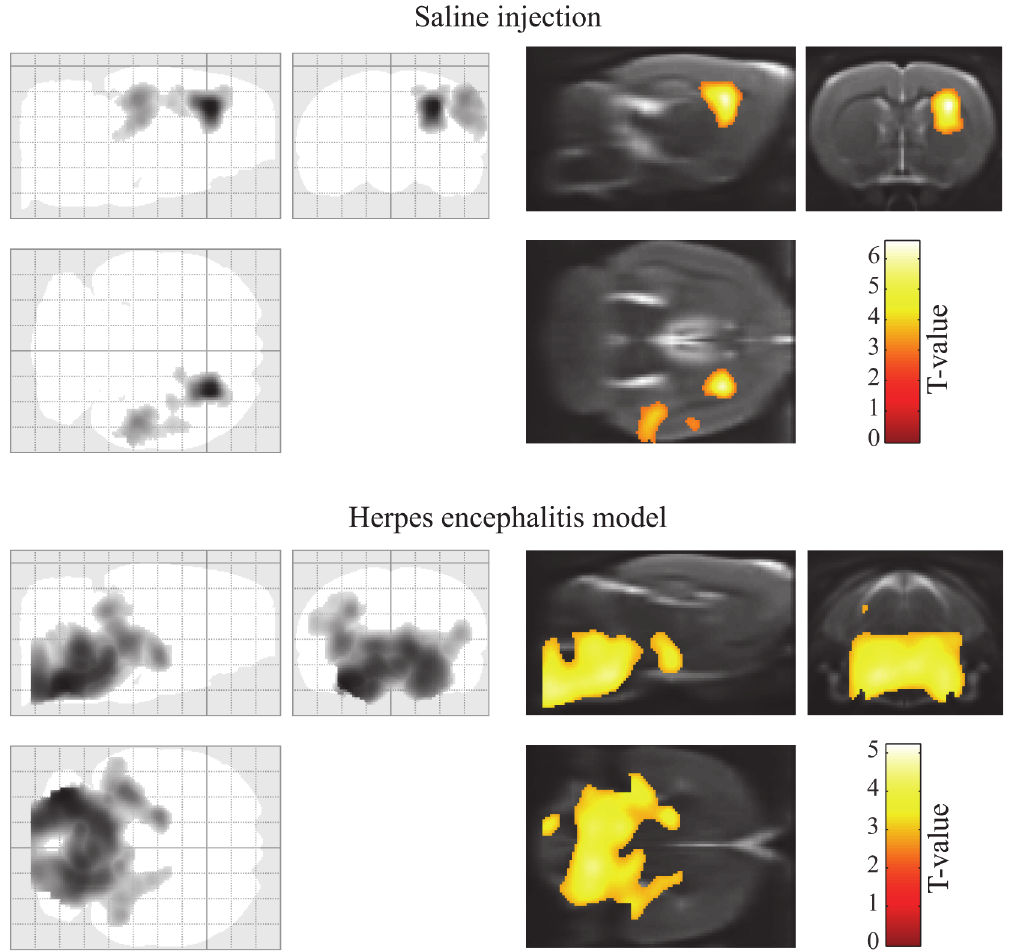
Fig 3. Voxel-based analysis. Statistically significant (p < 0.05 family-wise error corrected at cluster level) increased uptake of [ 11 C]PK11195 was found in lesion groups as compared with control animals. In the top section, the location of the stereotaxic injection of saline is clearly defined in the right corpus callosum and caudate-putamen. In the lower section of the figure, the results from the herpes encephalitis model showed a clear inflammatory process in the brainstem.